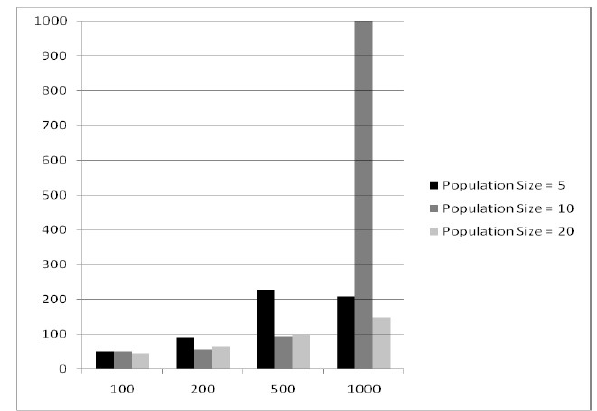
Figure 7. Execution time vs. input